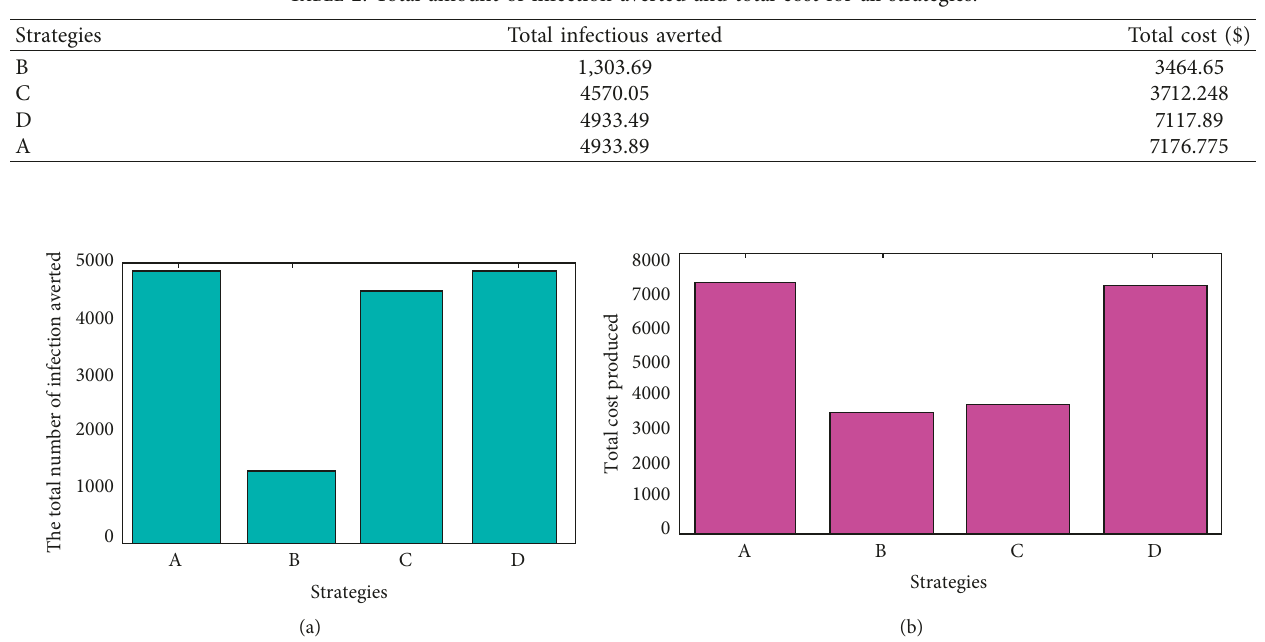
Table 2: Total amount of infection averted and total cost for all strategies.